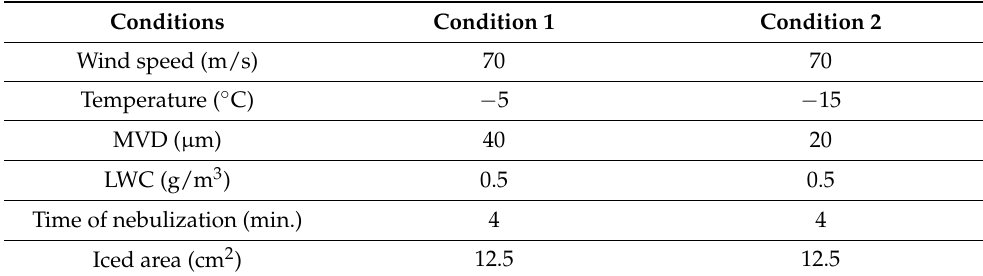
Figure 3. The ice was accreted in one half of the area of the 50 × 50 mm 2 samples using a mask to have an iced area of 12.5 cm 2 .